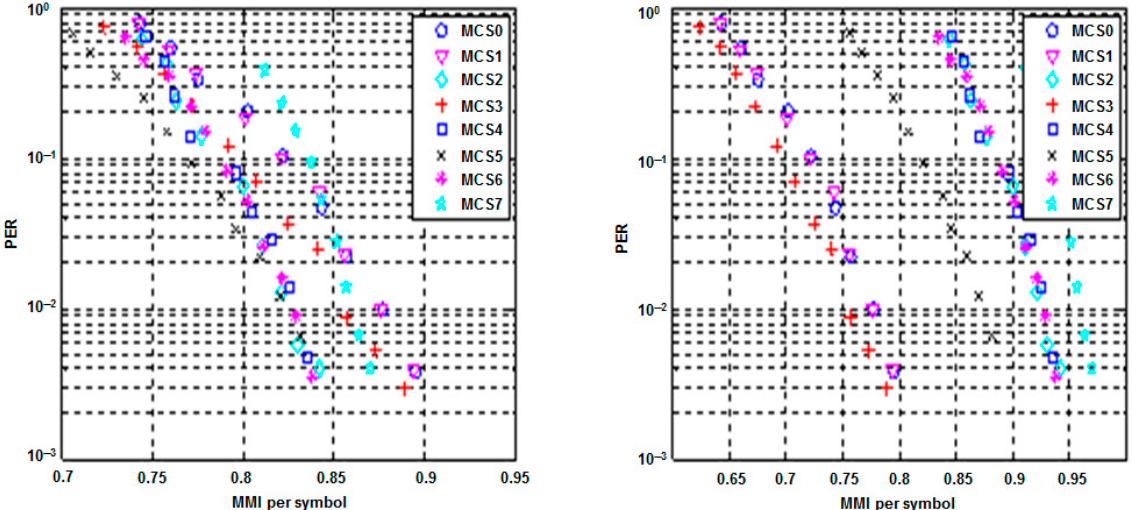
Figure 7. Randomly shifted ( left ) and standard ( right ) MMI-to-PER tables.